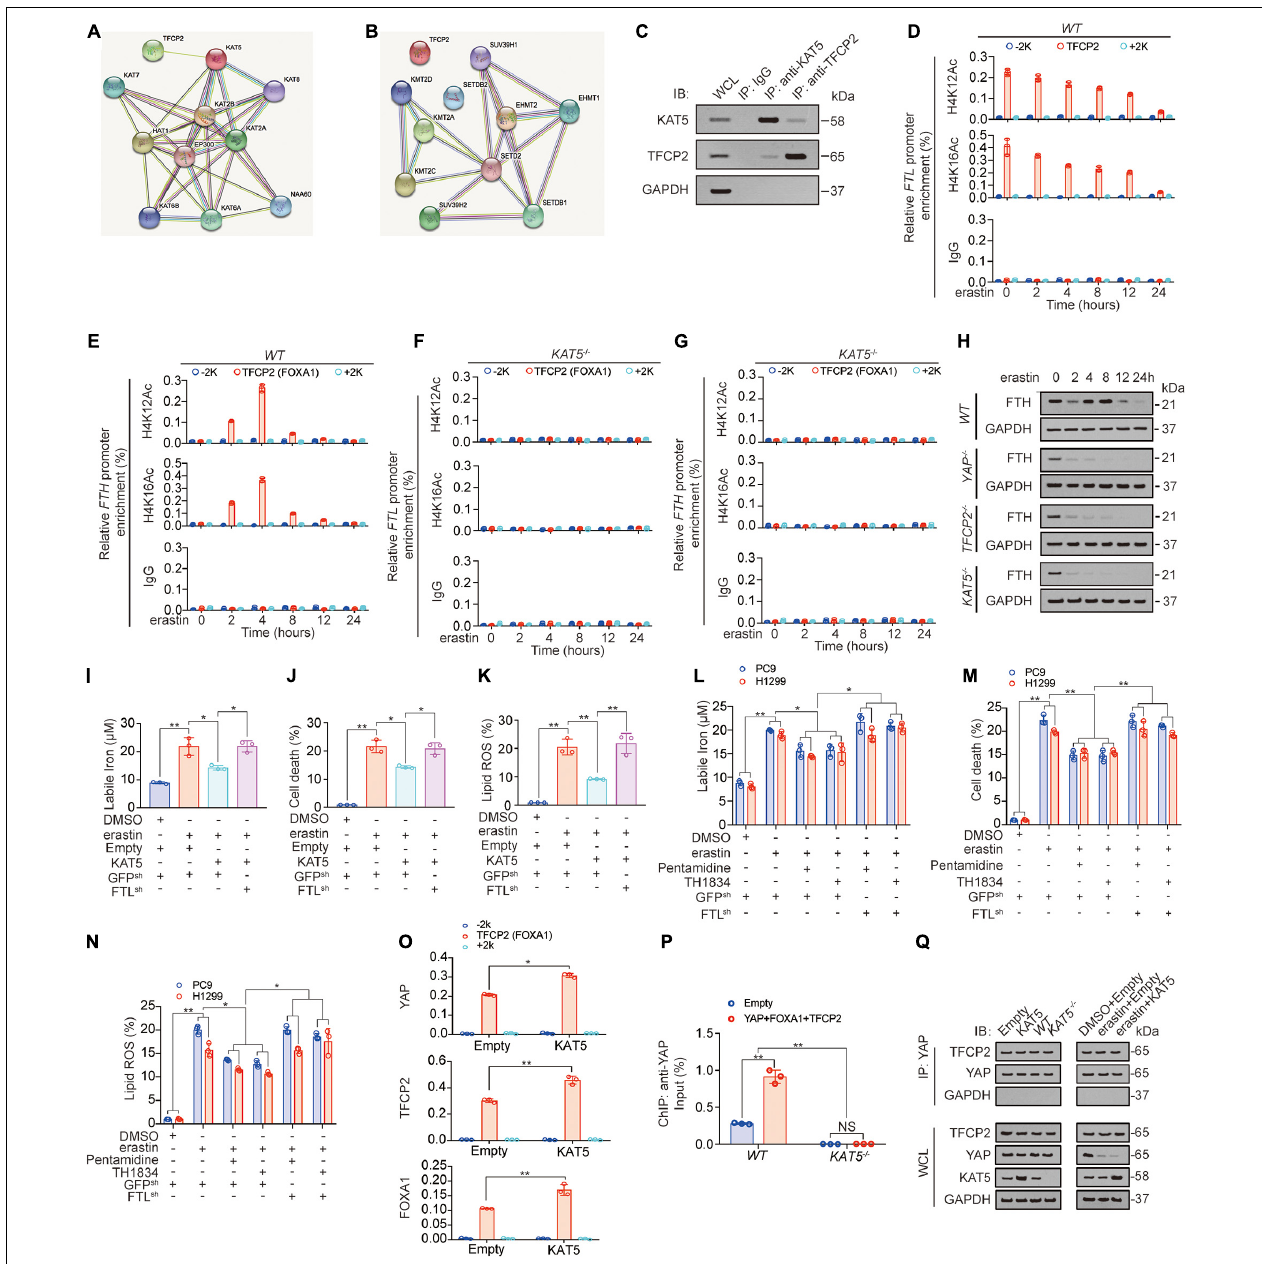
FIGURE 6 | KAT5-induced FTL acetylation suppresses ferroptosis. (A,B) STRING analysis revealed TFCP2 interacted acyltransferase (A) and methyltransferases (B) (confidence = 0.4). (C) Co-immunoprecipitation experiments performed in PC9 cells using IgG, anti-KAT5 and anti-TFCP2 antibodies, and further analysis of KAT5, TFCP2 and GAPDH expression by IB. (D–G) The enrichments of H4K12Ac and H4K16Ac at –2k, TFCP2 (FOXA1) motif or 2k regions of FTL (D,F) or FTH (E,G) promoter were calculated as the percentage of input chromosomal DNA via ChIP using the corresponding antibodies in WT (D,E) or KAT5 − / − (F, G) PC9 cells with erastin (10 µ M) treated for indicated times. IgG was used as the parallel control. (H) FTH expression were measured using IB in WT, YAP − / − , TFCP2 − / − and KAT5 − / − PC9 cells with erastin (10 µ M) treatment for indicated hours. (I–K) Labile iron, cell death and lipid ROS were measured in PC9 cells with or without KAT5 overexpression combined with FTL knockdown before erastin (10 µ M, 24 h or 16 h) treatment. (L,M) Labile iron, cell death and lipid ROS generation were measured in PC9 and H1299 cells with or without FTL knocked down. Pentamidine (30 µ M) and TH1834 (100 µ M) were used to pretreat cells for 8 h before further treated with erastin (10 µ M, 24 h). (N) The enrichments of YAP, TFCP2 and FOXA1 at –2k, TFCP2 (FOXA1) motif or 2k regions of FTL promoter were calculated as the percentage of input chromosomal DNA via ChIP using the corresponding antibodies in PC9 cells with or without KAT5 overexpressed. (O) Enrichment of YAP at TFCP2 (FOXA1)-binding motif within the FTL promoter in WT or KAT5 − / − PC9 cells with or without YAP, TFCP2 and FOXA1 overexpressed was measured by ChIP-qPCR. (P) Co-IP experiments were performed using anti-YAP in PC9 cells with KAT5 overexpression or knockdown with or without erastin treatment (10 µ M, 24 h). The YAP level in each co-IP samples was adjusted to the same protein content. The indicated proteins in co-IP samples or WCL were measured by IB. The data are shown as the mean ± SD from three biological replicates (including IB). * P < 0.05, ** P < 0.01 indicates statistical significance. Data in (I–M,O) were analyzed using a one-way ANOVA test. Data in (N) were analyzed using student’s t -test.